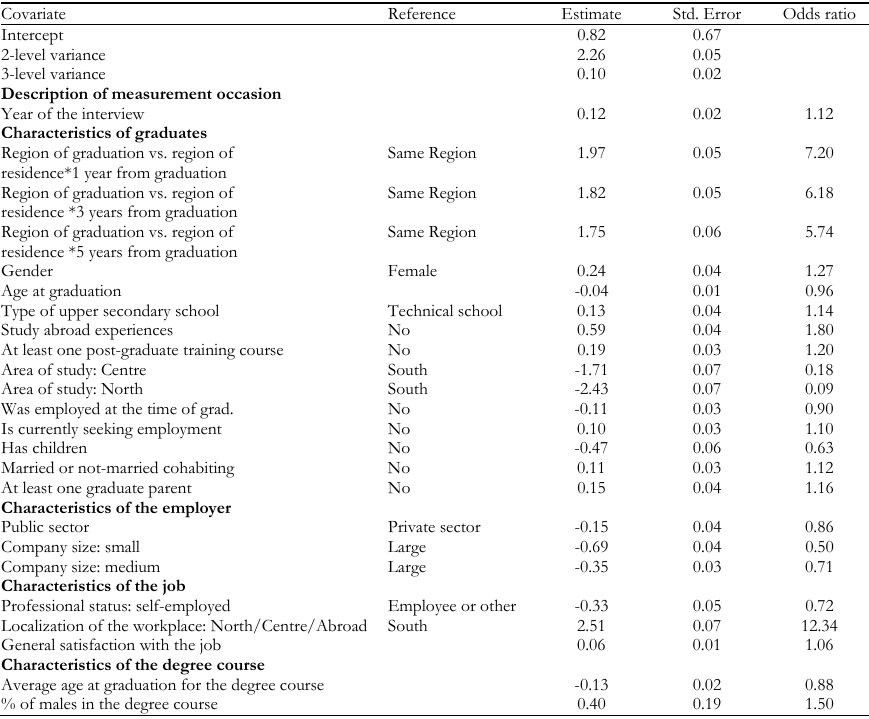
Three-level random intercept logistic model: regression coefficients estimates, standard errors, odds ratio